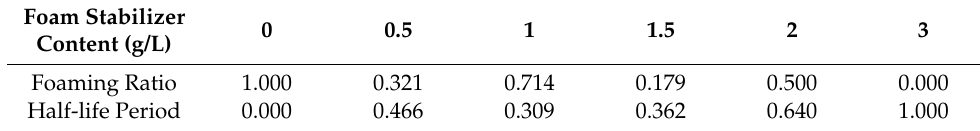
Table 4. Min-Max normalization results of foaming ratio and half-life period of foam.